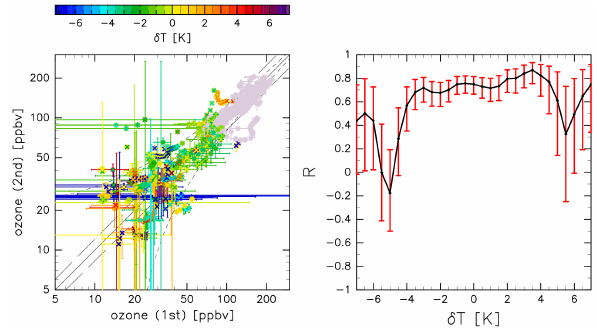
Fig. A5. As for Fig. A4 but for an examination of the acceptable advection time for the isentropic treatment.